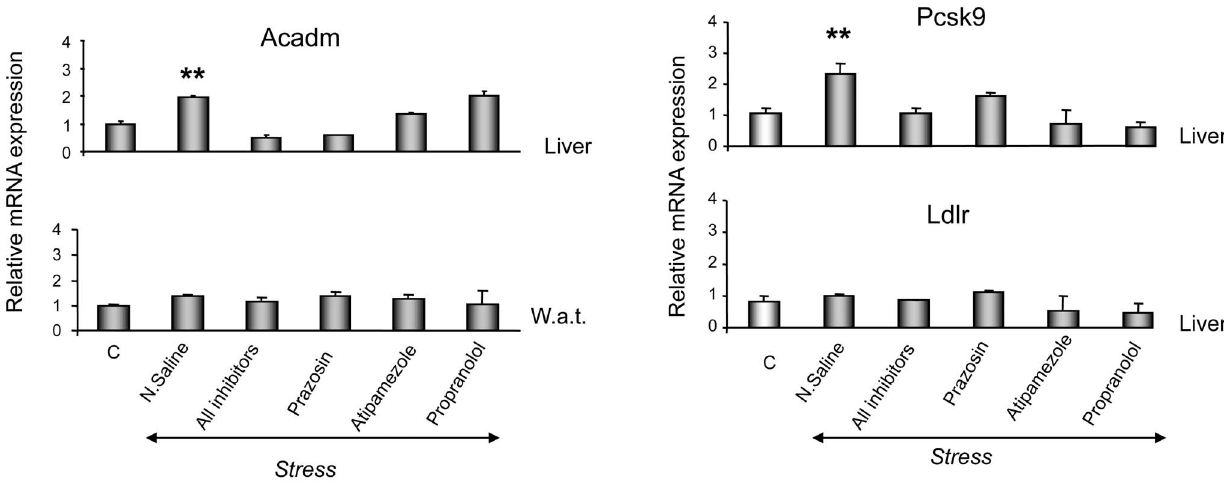
Figure 5. Stress-induced effect on Acadm expression. Effect of restraint stress and AR-related pathways on Acadm mRNA expression in the liver and in white adipose tissue (A), on Pcsk9 and Ldlr mRNA expression in the liver (B). Values were normalized to b -actin and are expressed as mean 6 SE (n=8–10). Comparisons were between controls and stress alone or coupled with AR-antagonists. AR: adrenergic receptor, C: control, N. Saline: normal saline, All inhibitors: mice were treated with all AR-antagonists prior to stress, prazosin (alpha 1 -AR antagonist), atipamezole (alpha 2 -AR antagonist), propranolol (beta-AR antagonist). **P , 0.01, ***P , 0.001.